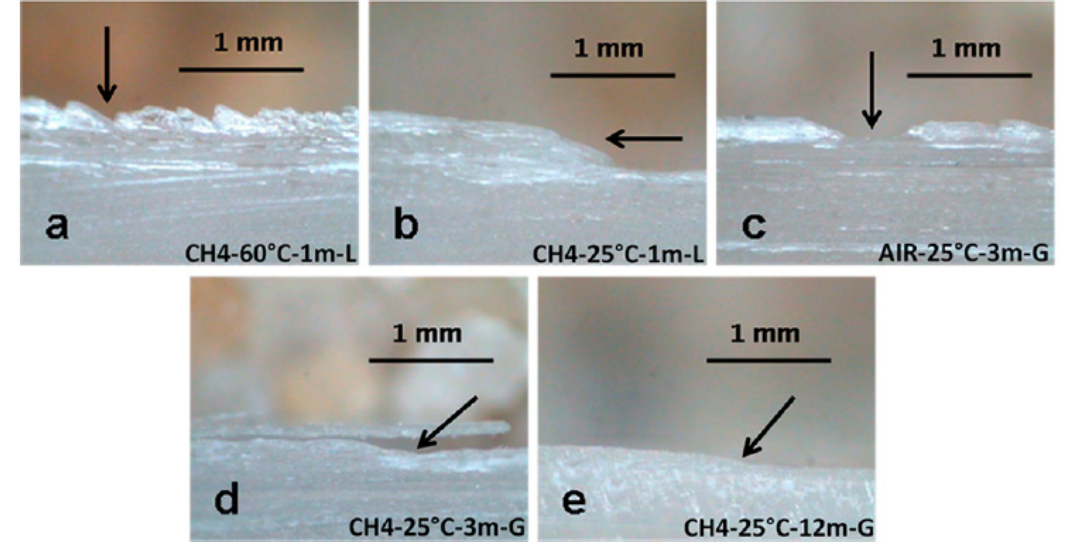
Figure 13. Structural damage detected in microclimatic simulations by Carreño-Márquez et al. (2018) [77]. Further permissions related to this figure should be directed to the American Chemical Society (ACS). ( a ) Irregular surface; ( b ) Slope; ( c ) Well; ( d ) Detachment; ( e ) Minor slope